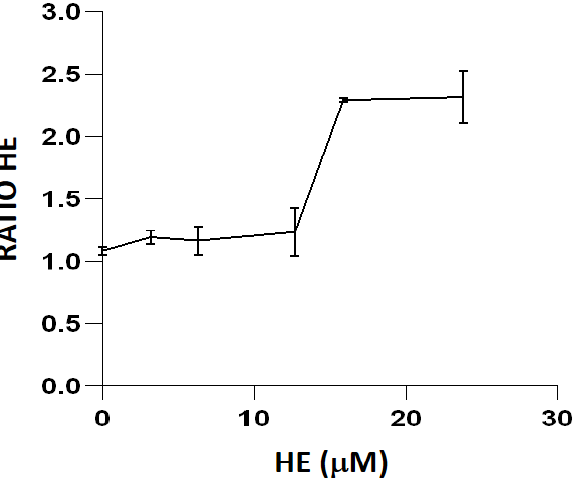
Figure 3. Titration of the fluorescent probe HE in strain IC5233 exposed to 0.29 mM menadione. Results are the mean ± SD (n = 3) of the fluorescence ratios of the product resulting from intracellular probe oxidation.